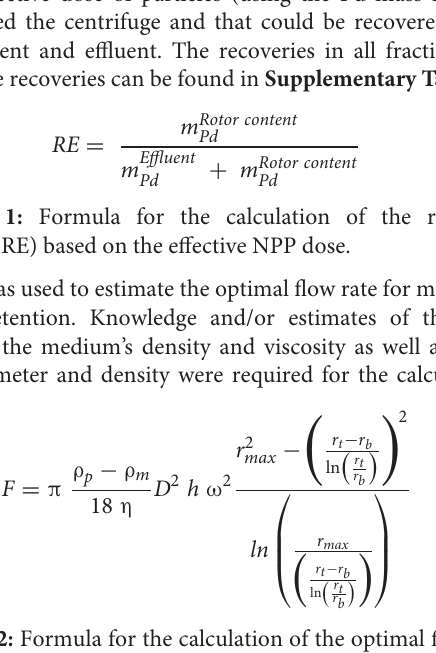
The effluent was sampled and analyzed without need for MWAD, as it was highly clarified through the centrifugation